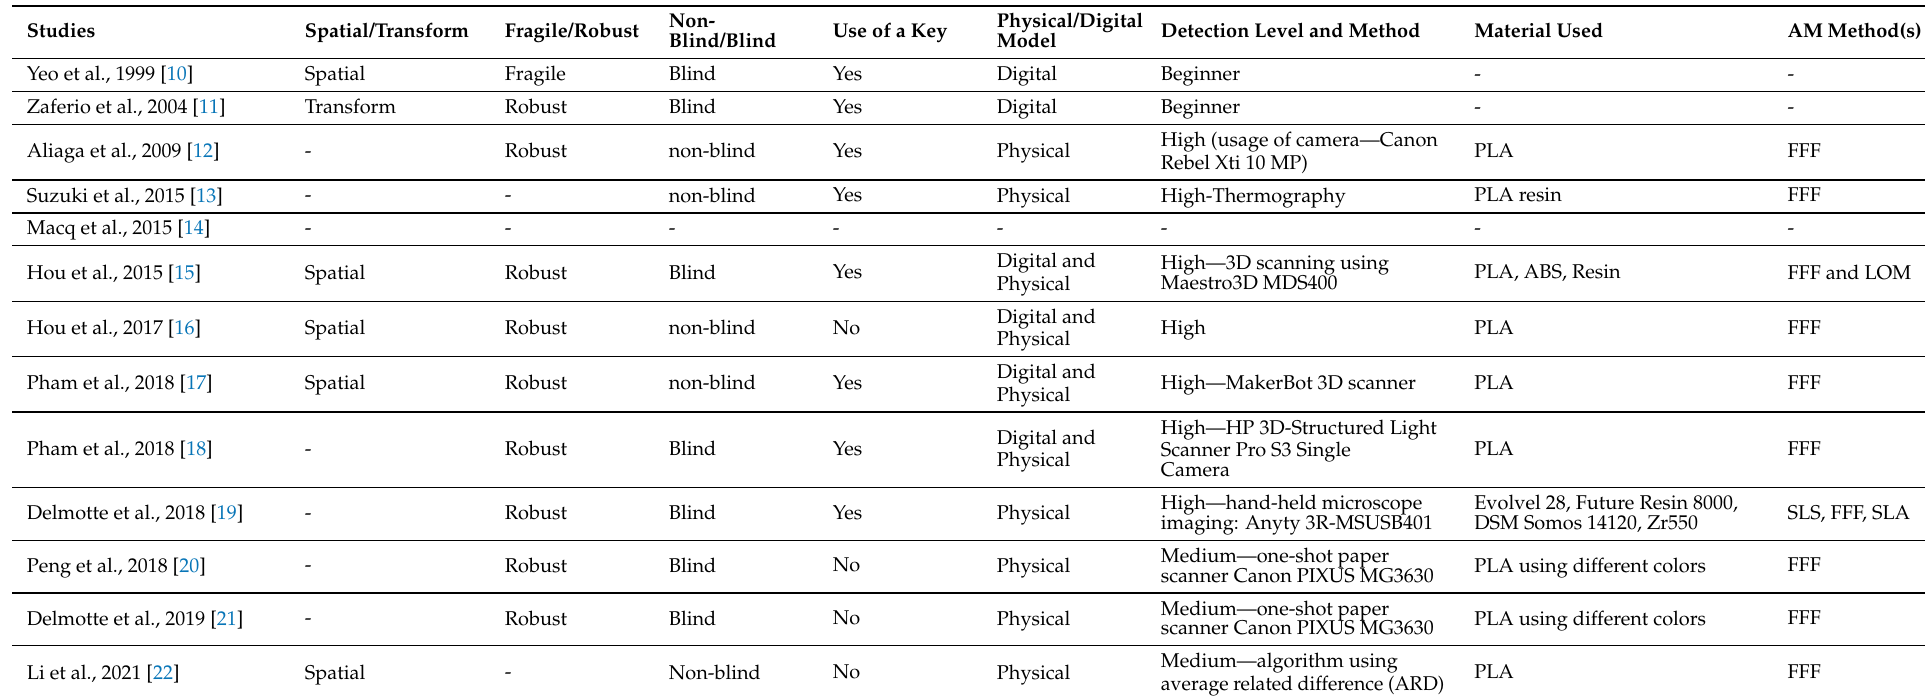
Table 2. Studies vs. watermarking